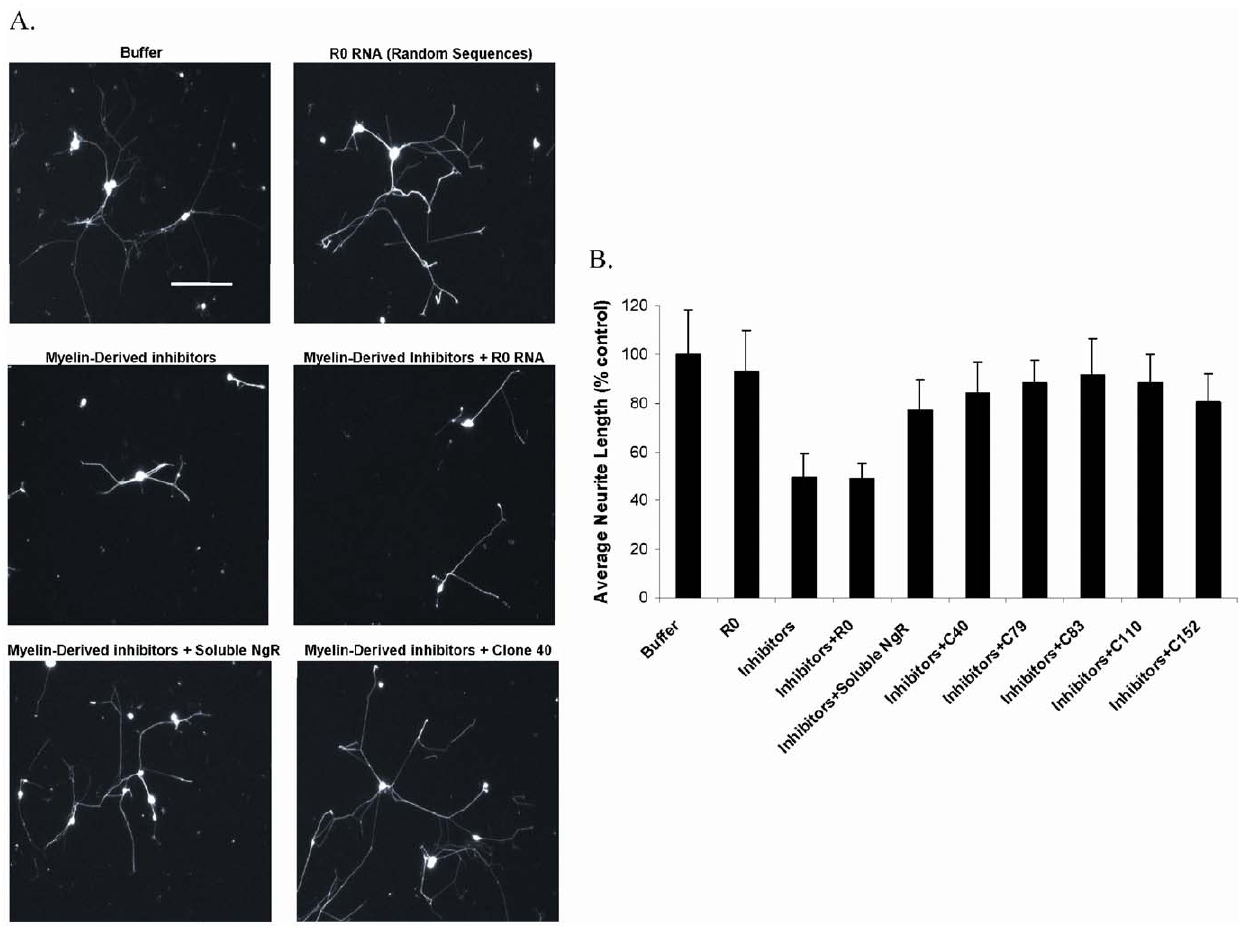
Figure 3. Neurite outgrowth assays with dorsal root ganglia. The myelin-derived inhibitors (Nogo, MAG, and OMgp) were added at 300 nM total (100 nM each). Aptamers (Clones 40, 79, 83, 110, and 152) were added at a concentration of 10 m M. (A) Visualization of neurite lengths. DRGs were stained with a neuron-specific anti-beta III tubulin antibody. The pictures shown are representative examples. Scale bar, 200 m m. (B) Average neurite lengths. Data was collected over 200–500 neurons per condition, and means + standard deviations are reported. Binding was normalized to a buffer alone control.